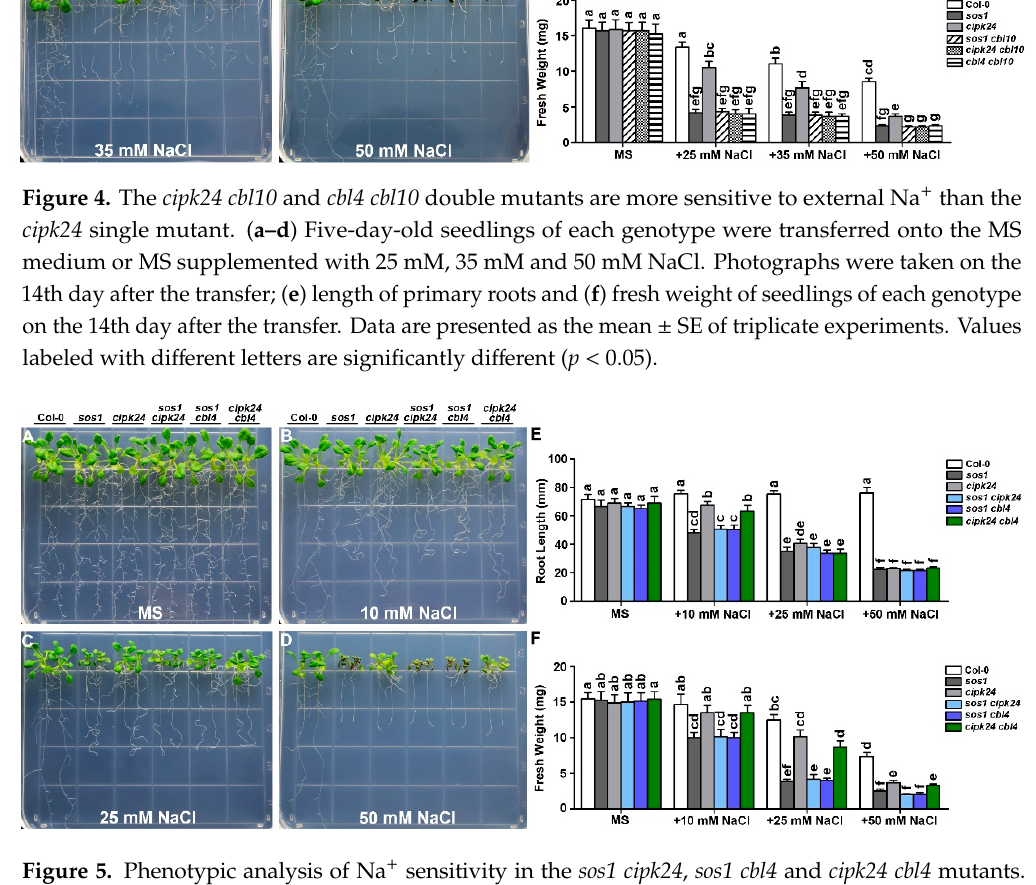
Figure 5. Phenotypic analysis of Na + sensitivity in the sos1 cipk24 , sos1 cbl4 and cipk24 cbl4 mutants. ( a–d ) Five-day-old seedlings of each genotype were transferred onto the MS medium or MS supplemented with 10 mM, 25 mM and 50 mM NaCl. Photographs were taken on the 14th day after the transfer; ( e ) length of primary roots and ( f ) fresh weight of seedlings of each genotype on the 14th day after the transfer. Data are presented as the mean ± SE of triplicate experiments. Values labeled with different letters are significantly different ( p < 0.05).